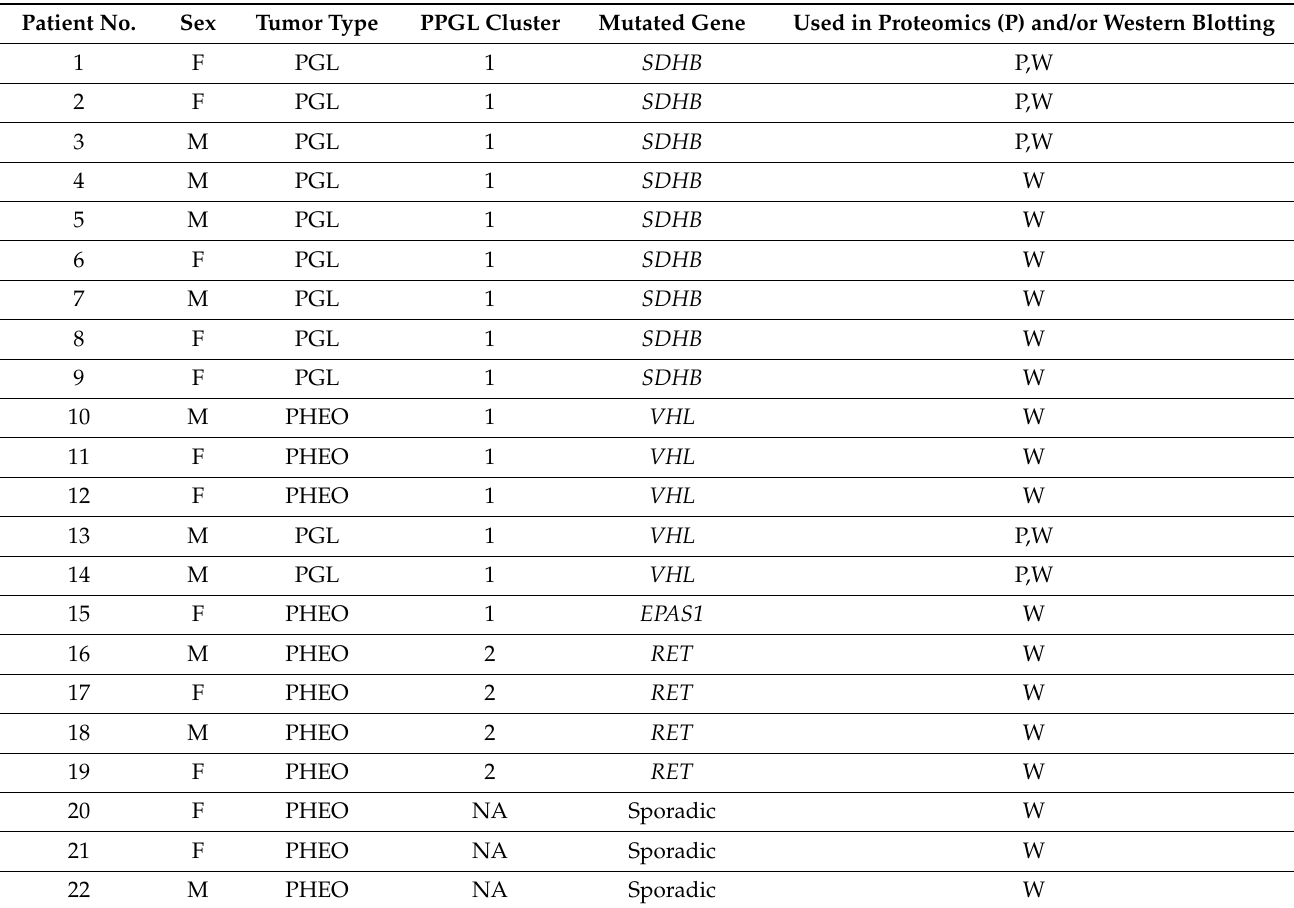
Table 1. Patient and sample